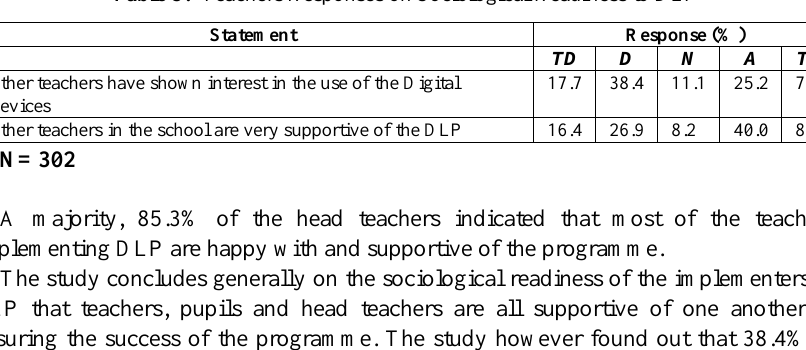
Table 3 indicates the responses of the teachers on Sociological Readiness to DLP Table 3. Teachers Responses on Sociological Readiness to